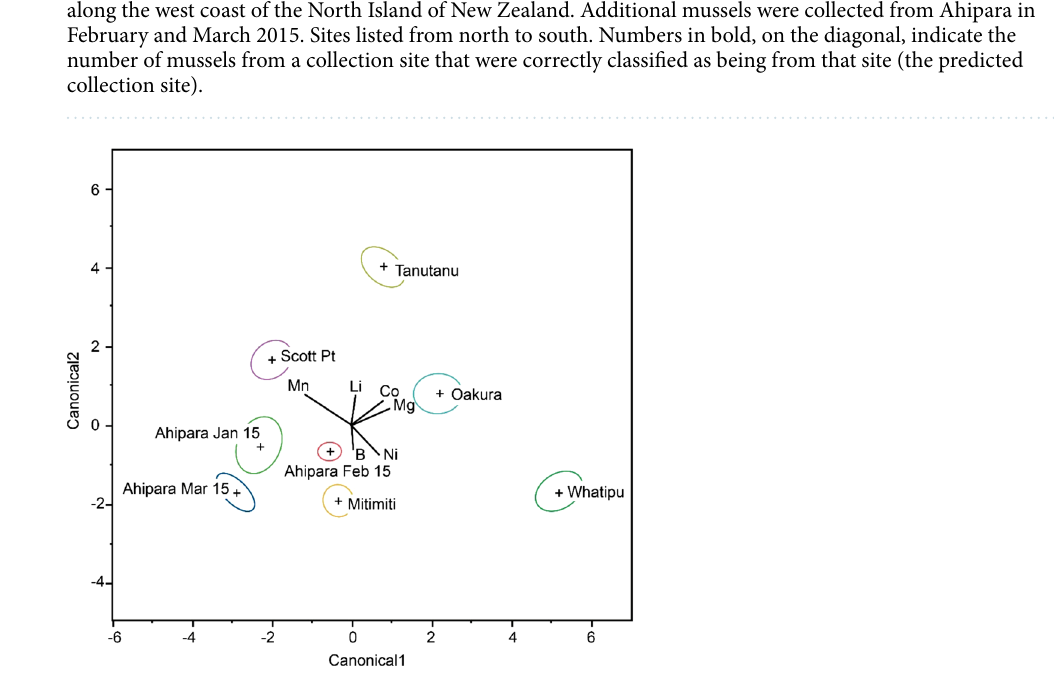
Figure 2. Average (cross symbol) and 95% confidence intervals (coloured ellipses) of canonical scores from quadratic discriminant function analysis of ratios of TE :Ca to B, Co, Li, Mg, Mn and Ni in shells of juvenile P. canaliculus collected from six sites within the North Island of New Zealand in January 2015. To gain an understanding of temporal variation samples were also collected in February and March at Ahipara. Direction of spread of site-specific samples is explained by elemental directions shown in the centre of the